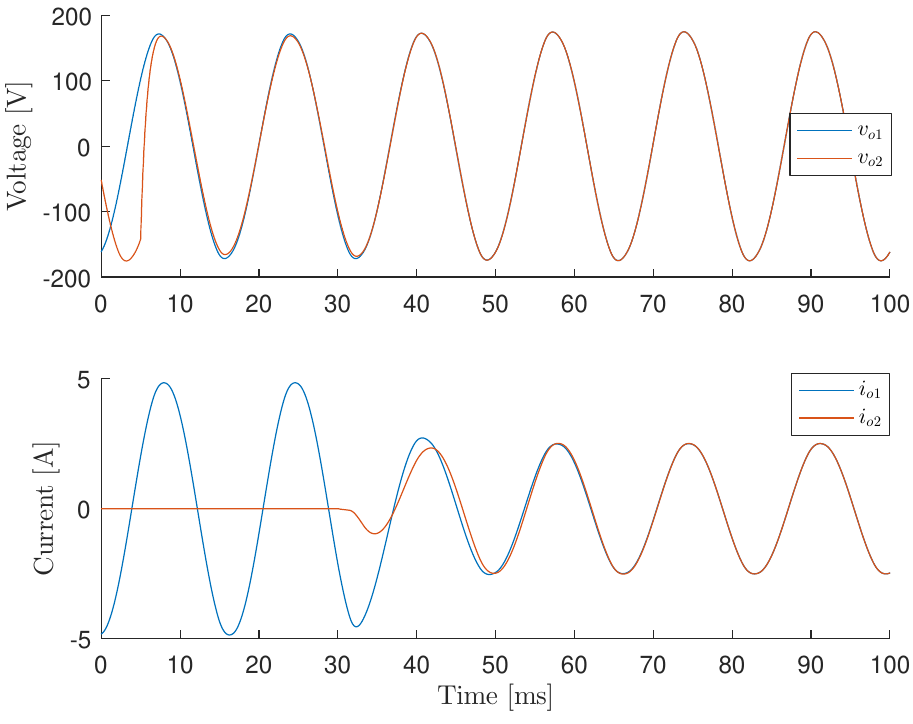
Figure 10. Synchronization of two oscillators designed with PM with pre-synchronization.